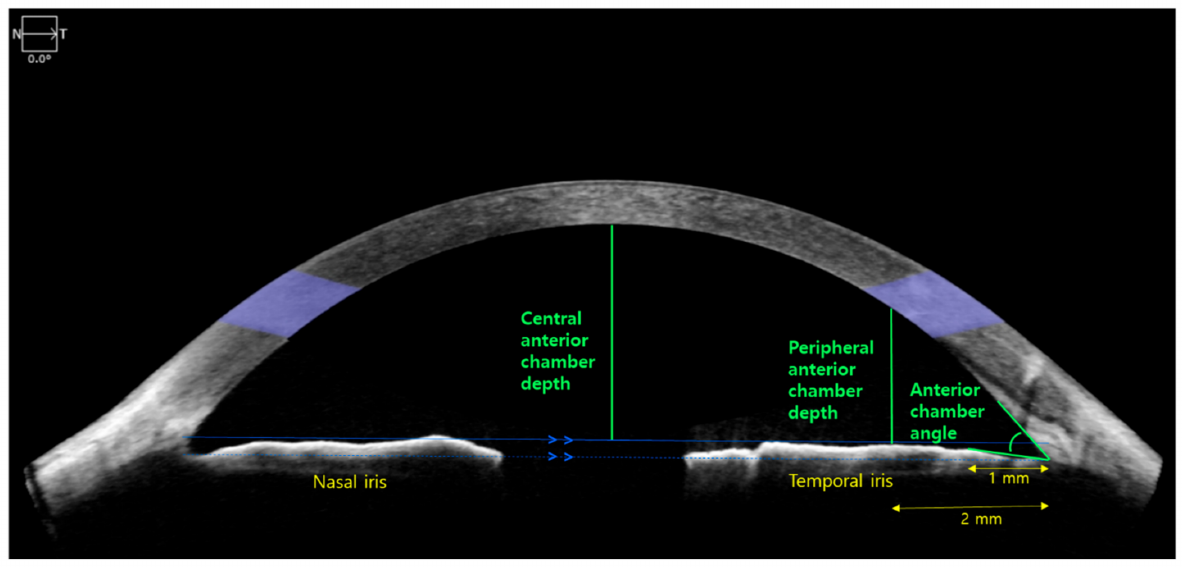
Figure 1. Anterior segment optical coherence tomography (AS-OCT) parameters. Among the four anterior chamber (AC) parameters used in this study, central anterior chamber (CAC) depth, peripheral anterior chamber (PAC) depth, and AC angle were measured using an integrated ruler and angle indicator. For the AC area, the value was measured automatically by